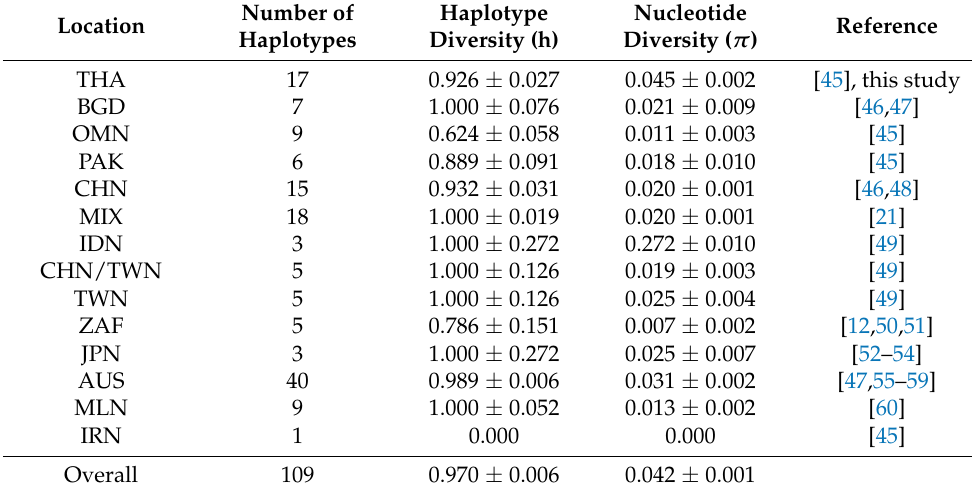
Table 2. The number of haplotypes, haplotype diversity, and nucleotide diversity of T. aduncus worldwide. Number of Location Haplotypes